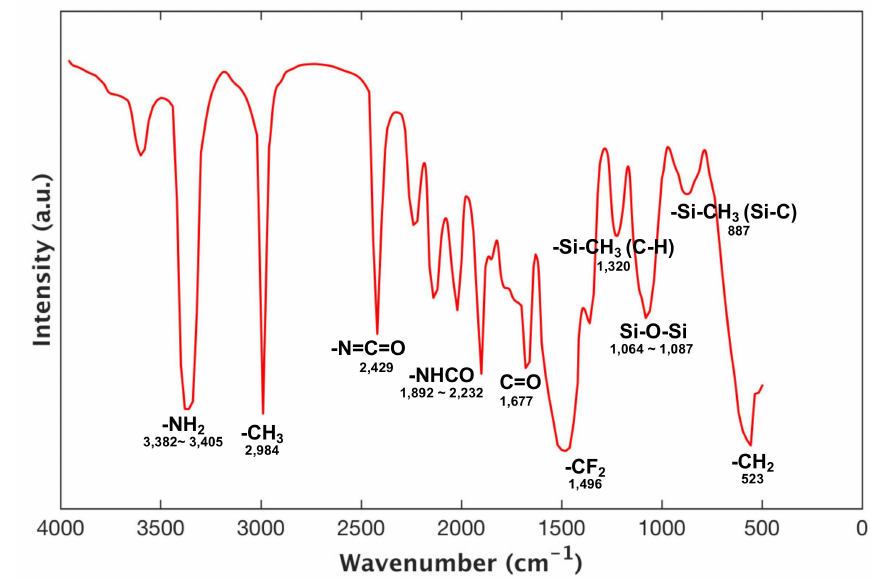
Figure 3. FTIR spectra of